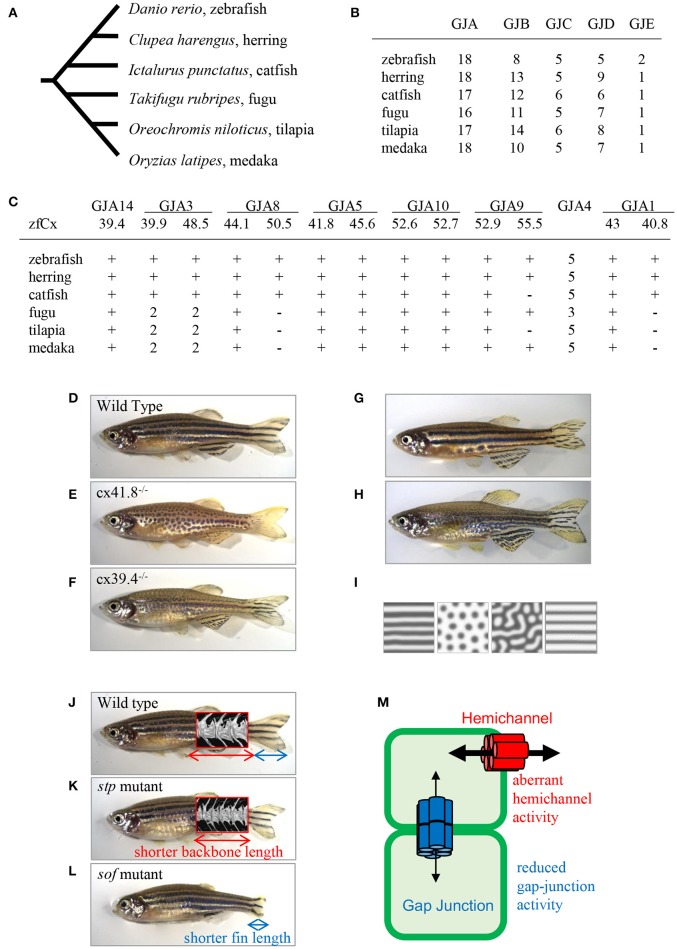
Connexins in teleosts. (A) Phylogenic relationship among six teleost species (Chen et al., 2004). (B) The number of connexin-encoding genes in six teleost species. (C) The number of genes encoding connexins of the alpha family gap junctions. “zfCx” indicates zebrafish connexins; “+” and “−” indicate the existence or absence, respectively, of an ortholog. If more than one orthologous gene was found, gene numbers are indicated (B,C; Connexin sequences were obtained from genome data base in Sanger Institute, http://www.sanger.ac.uk/). (D–I) Connexins in zebrafish pigment patterns. Wild-type zebrafish (D; Watanabe and Kondo, 2012); leopard mutant (E; Watanabe and Kondo, 2012); luchs mutant (F; Irion et al., 2014; Watanabe et al., 2016); transgenic zebrafish Tg(mitfa-cx41.8) >> leopard (G; Watanabe and Kondo, 2012); transgenic zebrafish Tg(mitfa-cx41.8M7) >> wild-type (H; Watanabe and Kondo, 2012); reaction-diffusion (R-D) patterns (I; Watanabe and Kondo, 2012). (J–M) Connexins in zebrafish bones; micro-CT images of vertebrae are superimposed. Wild-type zebrafish (J; Misu et al., 2016), stp mutant (K; Misu et al., 2016), sof mutant (L; Iovine et al., 2005; Misu et al., 2016). Schematic presentation of gap junction and hemichannel functions in zebrafish mutants (M; Misu et al., 2016). Red font, functional activity of hemichannels in the stp-Cx43 mutant; blue font, functional activity of gap junctions in the sof-Cx43 mutant.